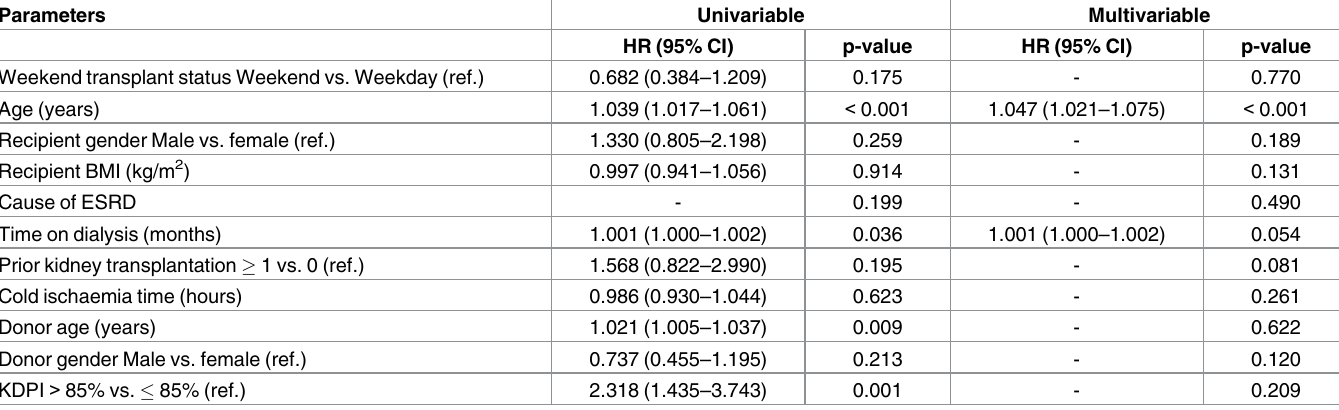
Table 3. Cox regression model for overall graft survival.